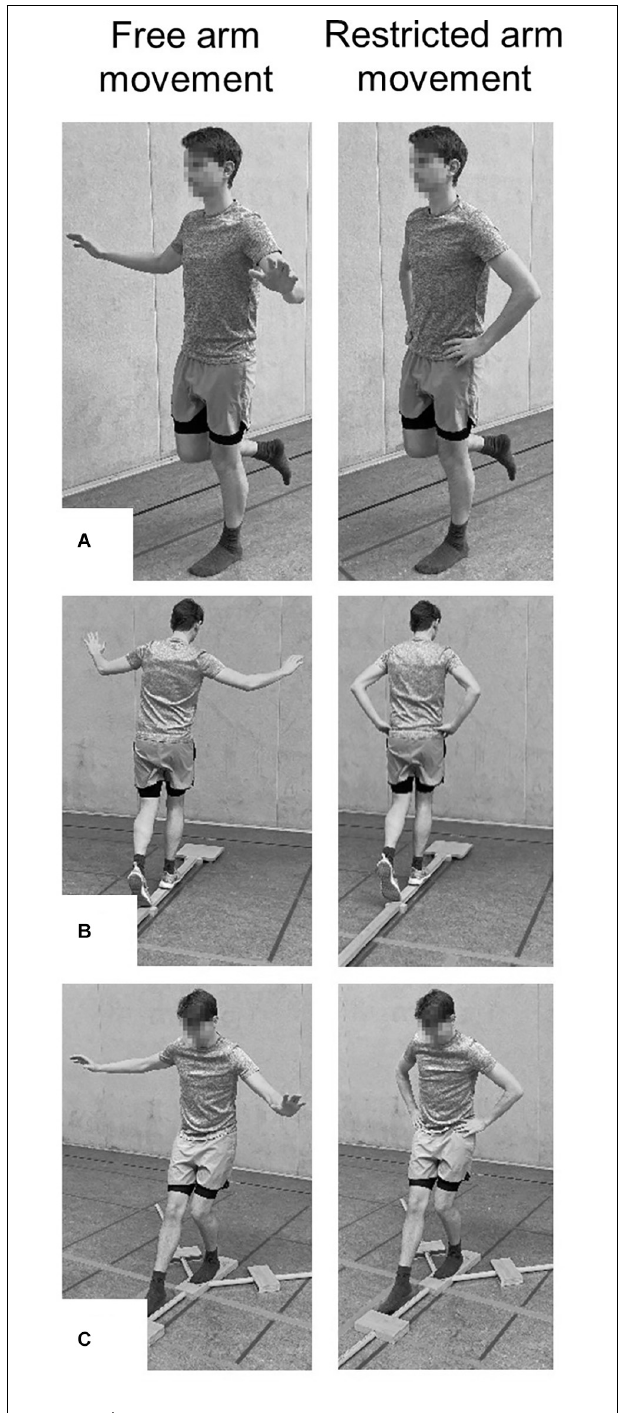
FIGURE 1 | Setup for the assessment of balance using (A) the one-legged stance test (i.e., eyes opened, firm ground condition), (B) the 3-m beam walking backward test (i.e., beam width: 6 cm), and (C) the Lower Quarter Y Balance test (i.e., anterior reach direction).